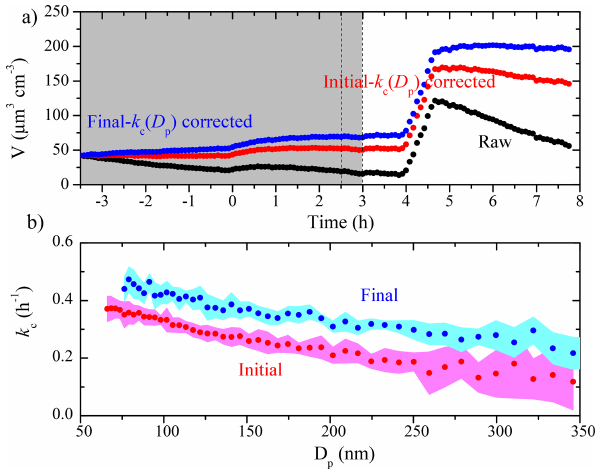
Figure 9. The coagulation-corrected particle wall-loss rate constant, k c , at each diameter derived from experiments with only ammonium sulfate particles in the 12m 3 CMU Teflon chamber before and after some major maintenance in the room where the chamber is sus- pended. The chamber was partially deflated and its walls subjected to friction repeatedly during the